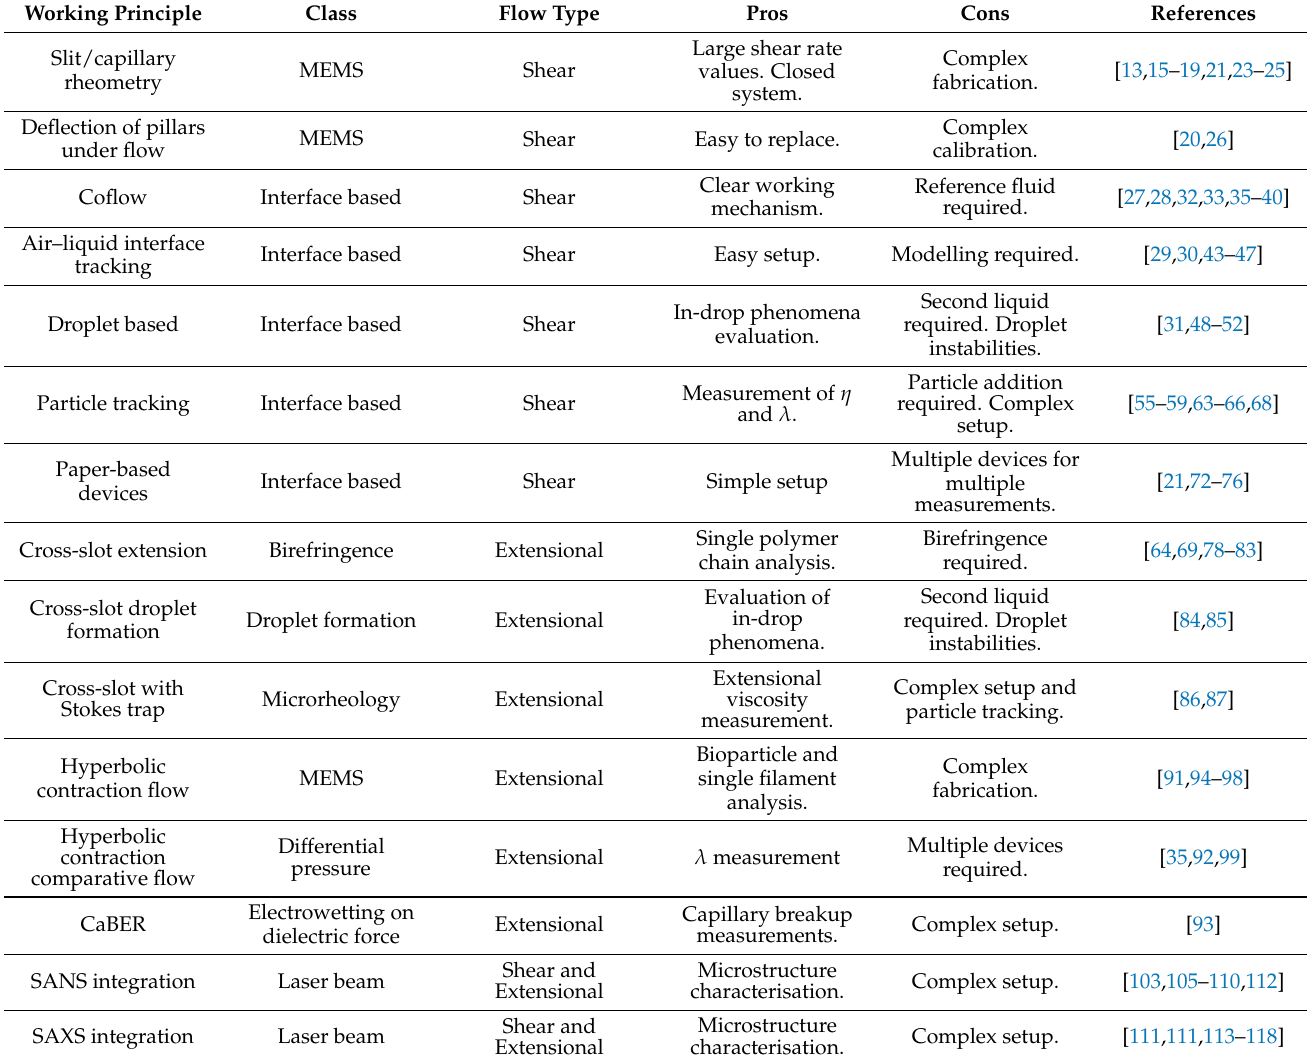
Table 1. Overview of the microfluidic rheometers reviewed